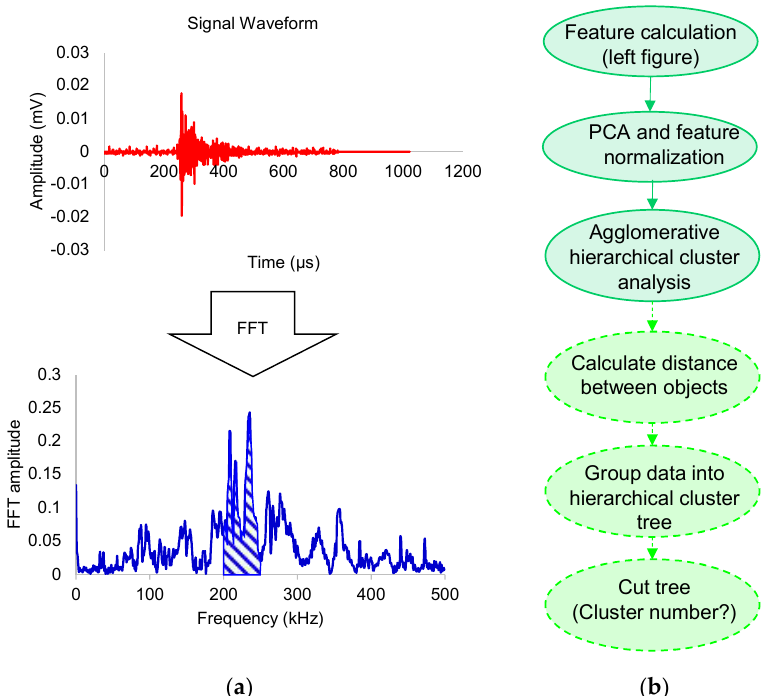
Figure 3. Clustering procedure. ( a ) Energy-frequency based feature extraction; ( b ) Flow chart of data clustering steps.